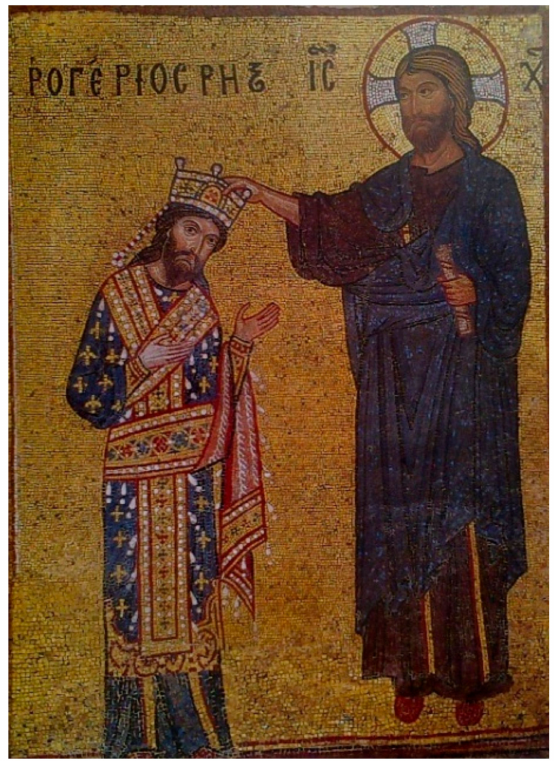
Figure 5. Christ Crowning Roger II , mosaic, 1143–1149. Palermo, Church of Santa Maria dell’Ammiraglio. Photo took by